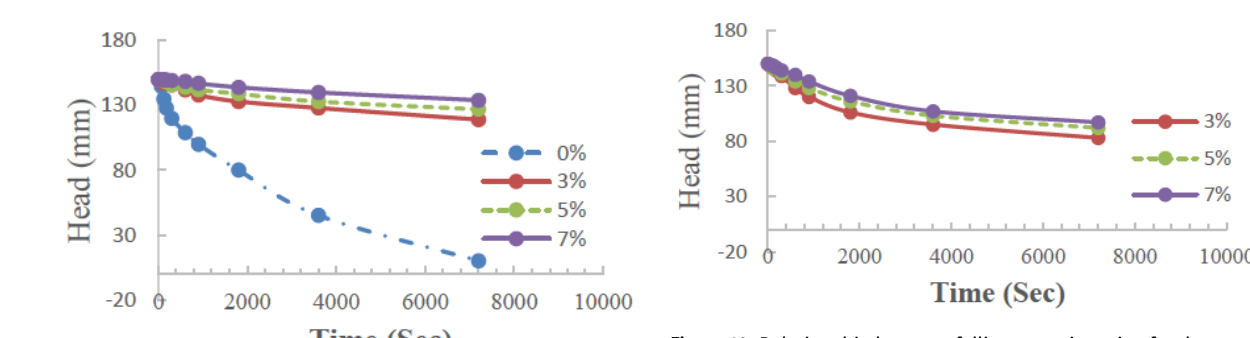
Figure 10: Relationship between falling water in a pipe for the con- stant head permeability test and the duration of time for 3%, 5%, and 7% stabiliser-treated soil after 55 days of soaking